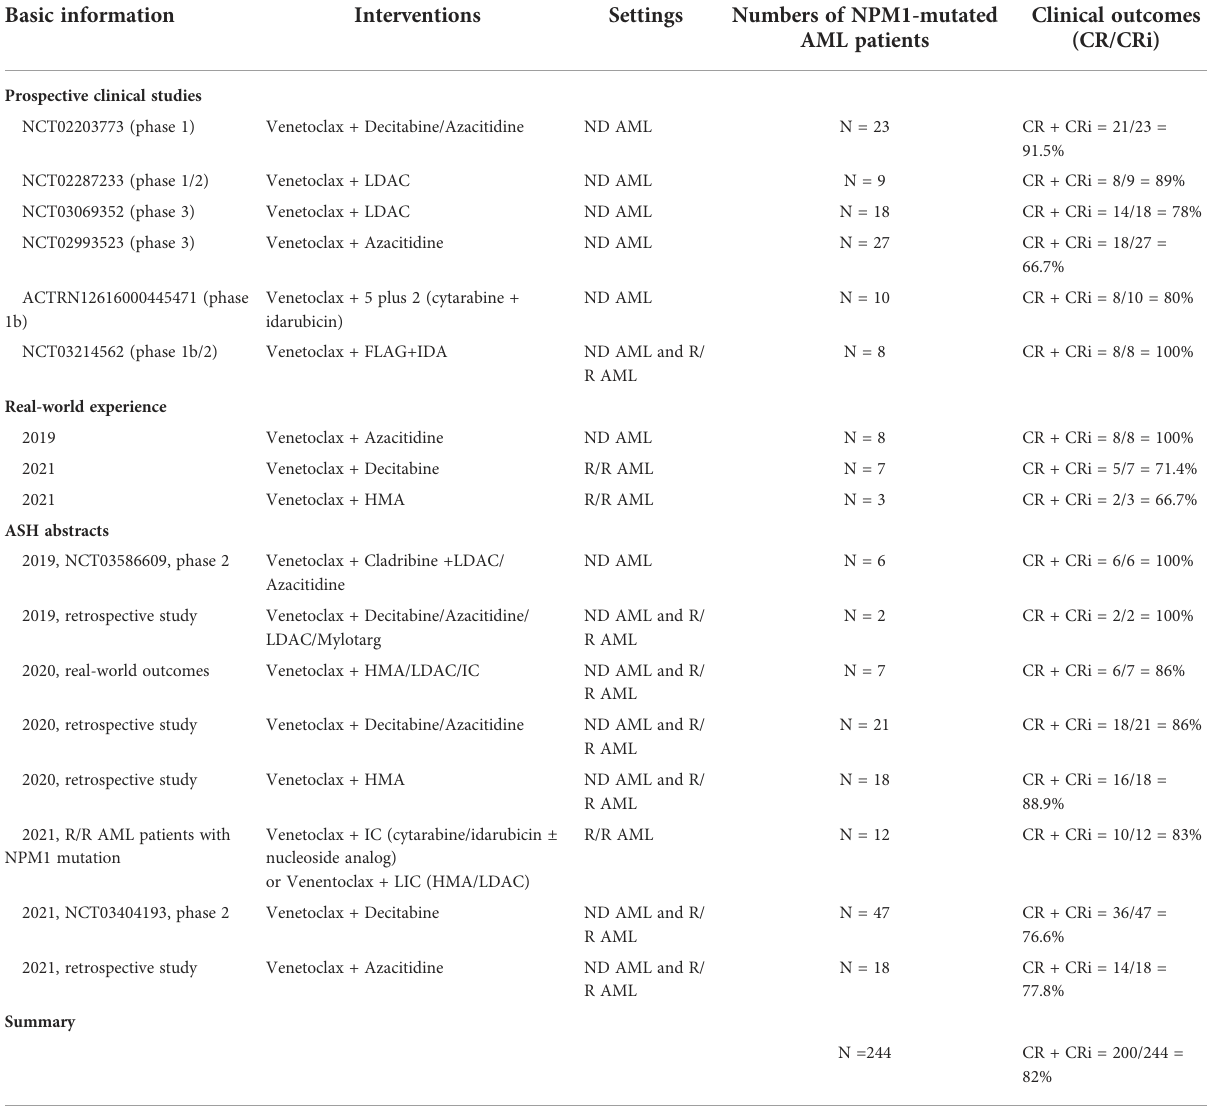
TABLE 1 Summary of venetoclax-based therapies in NPM1-mutated AML. Basic